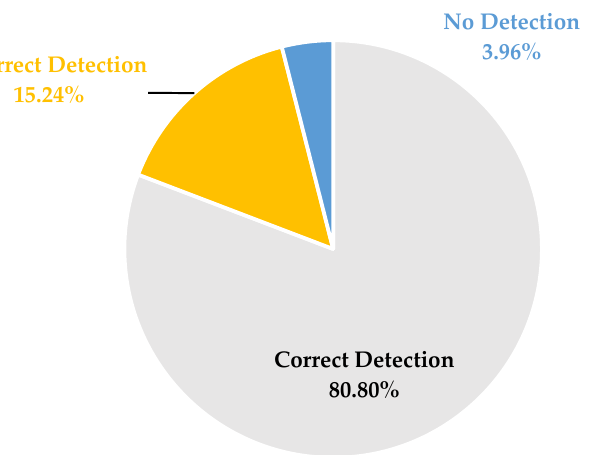
Figure 11. Equipment detection performance results during the initial experimental test.